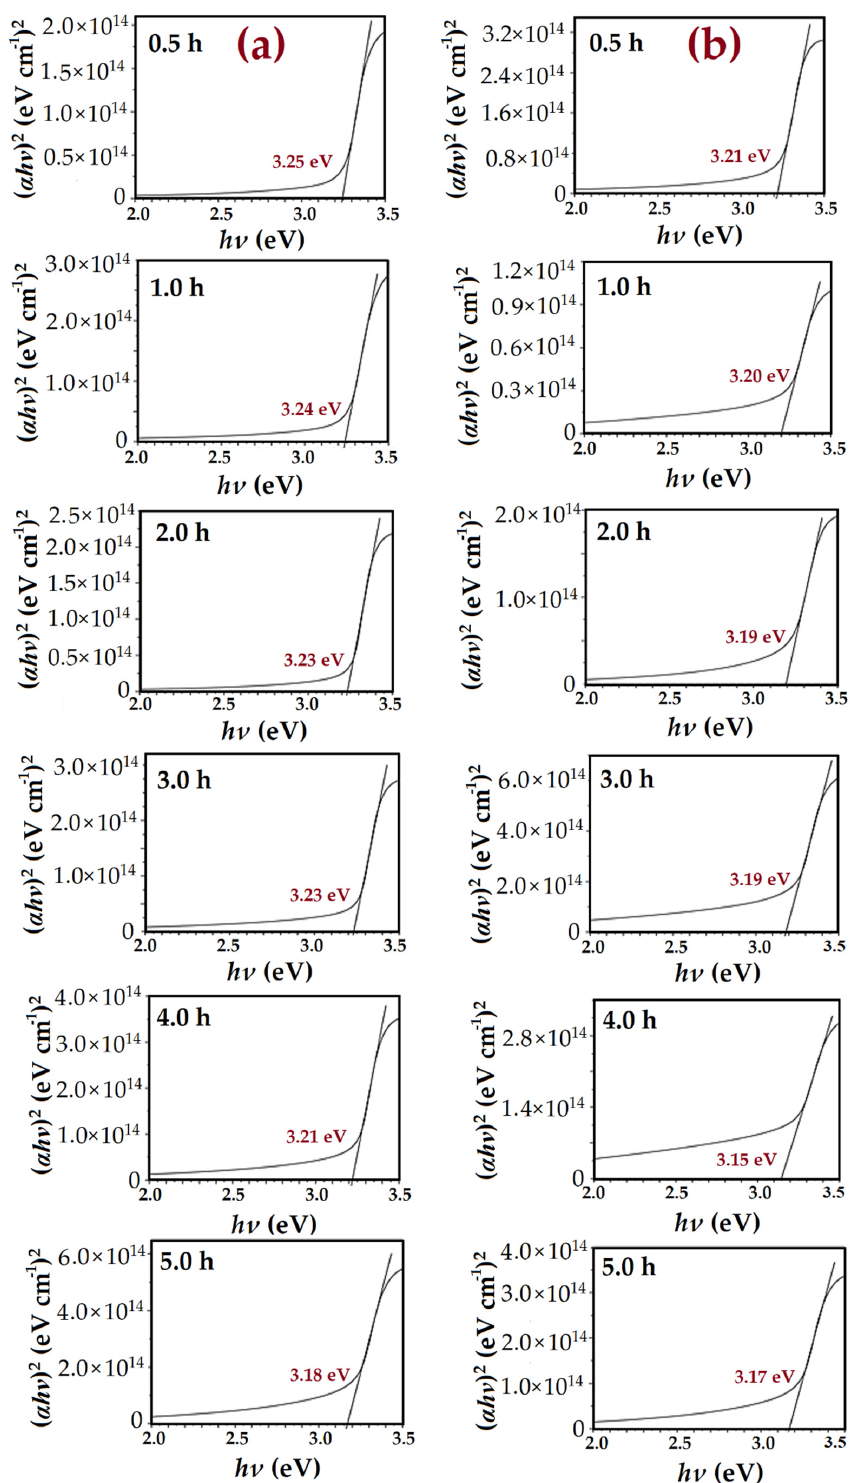
Figure 2. Electrical system for electrical current-voltage (I-V) characteristics measurement of UV Figure 16. Variation of ( α h ν ) 2 against applied energy band gap ( h ν ) of the ZnO nanorods synthesized photodetectors. at diverse growth times: ( a ) conventional CBD method and ( b ) modified CBD